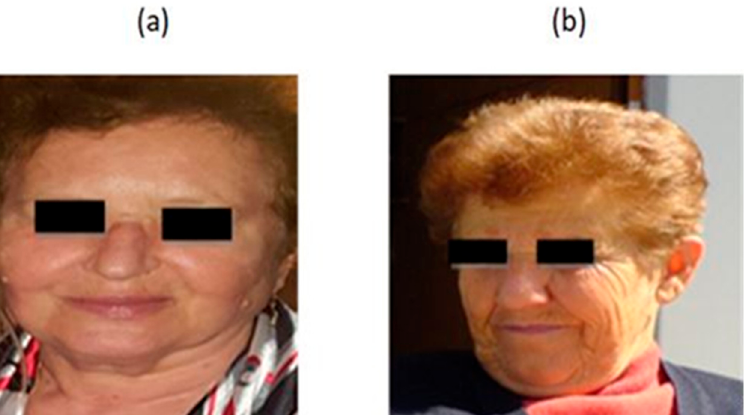
Figure 1. ( a ) Biological aging. A 72 year-old-woman, who lives in an urban city, uses suncream, drinks water >1.5 L per day, and eats fruits and vegetables daily. ( b ) Photoaging. A 68-year-old woman who lives in a village in Greece. She is a farmer, does not use suncream and does not like to eat fruits and vegetables. The woman in ( b ) is younger than the woman in picture ( a ), but her skin has signs of premature aging (deep wrinkles, dull skin, intense relaxation. (Archival material by courtesy of Dr. Foteini Biskanaki, 2020).